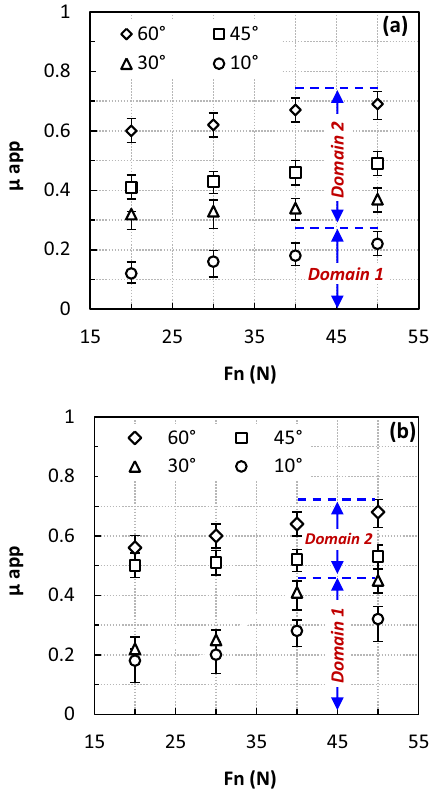
vs normal load for ( a ) SST // and ( b ) SST ⊥ app